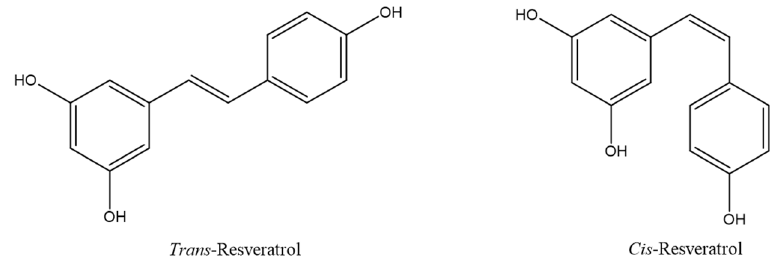
Figure 1. Chemical structures of trans -resveratrol and cis- resveratrol.